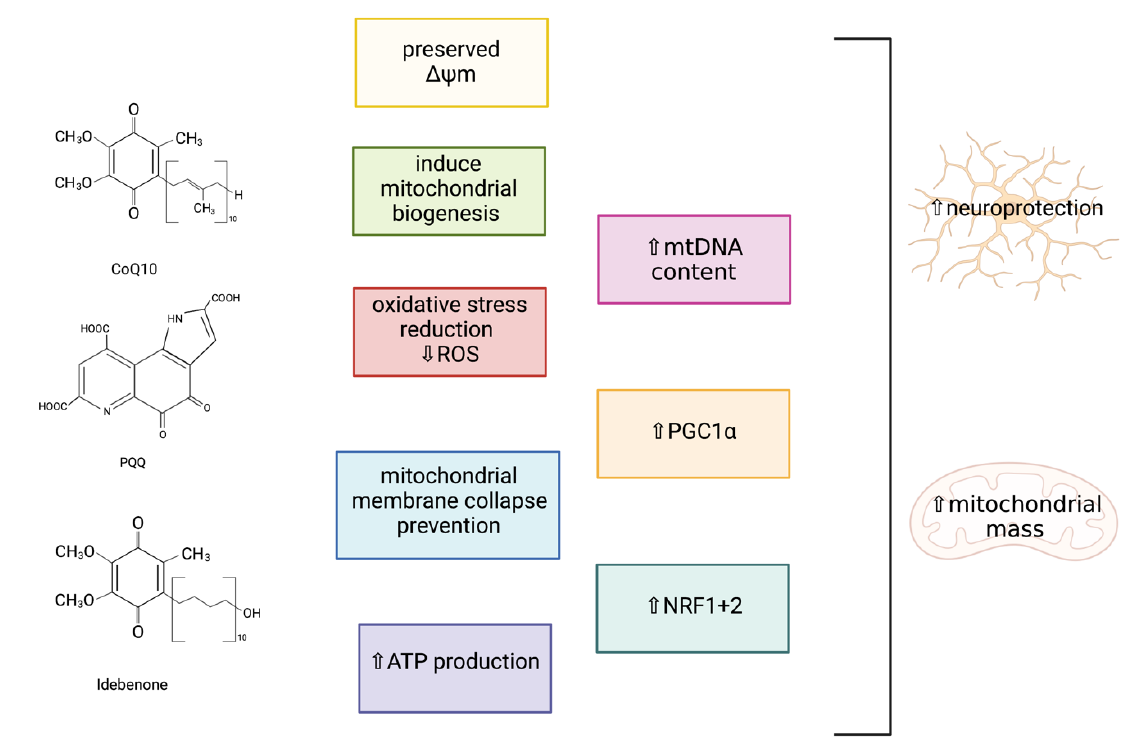
Figure 10. Summary of the neuroprotective effects of the following bioactive quinones: coenzyme Q10, pyrroloquinoline quinone, and idebenone. These compounds have been reported in the literature as having roles as neuroprotective agents, in addition to upregulating the mitochondrial mass and function in neurodegeneration (created using biorender.com). CoQ10—coenzyme Q10; PQQ—pyrroloquinoline quinone; ∆Ψ m—mitochondrial membrane potential; ROS—reactive oxygen species; ATP—adenosine triphosphate; mtDNA—mitochondrial DNA; PGC1 α —peroxisome proliferator-activated receptor gamma coactivator 1-alpha; NRF1 + 2—nuclear respiratory factor 1 +